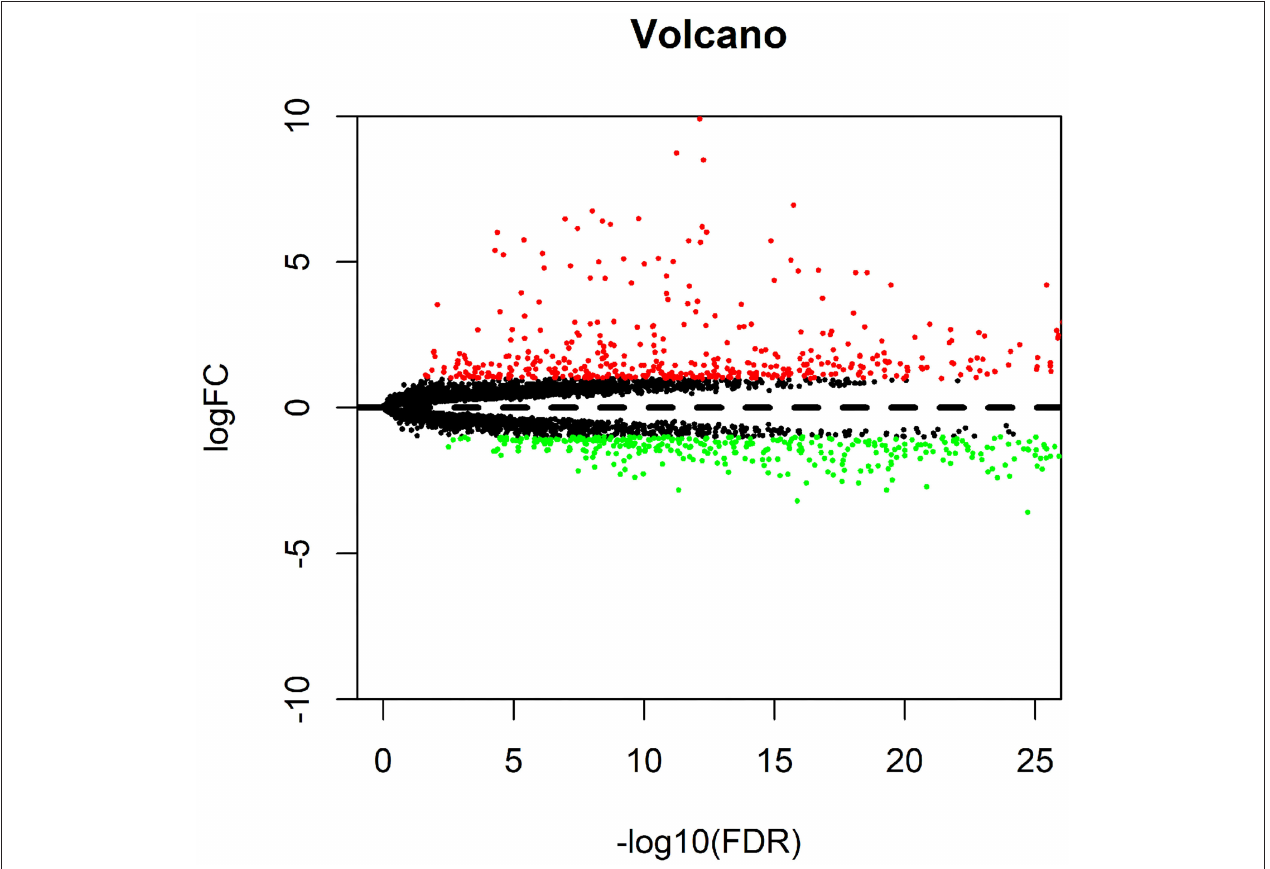
FIGURE 1 | Differential analysis of data in the TCGA-LIHC samples. The volcano map for differential genes is presented, in which the X-axis represents -log10 (FDR), and the Y-axis represents logFC. Each dot in the map represents a gene, where the red dots represent the upregulated genes in HCC, and the green dots represent the downregulated genes in